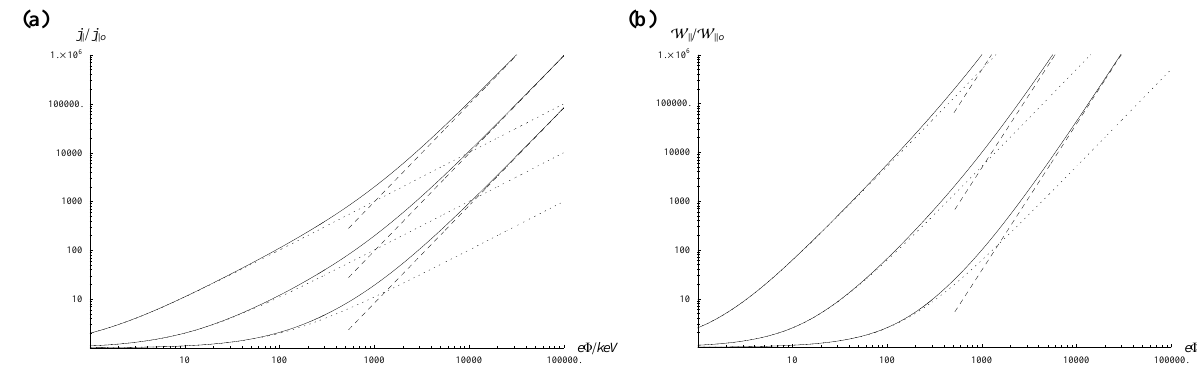
Fig. 5. Plots showing the variation of (a) the normalised field-aligned current density (cid:0) j || (cid:14) j || o (cid:1) (or number flux), and (b) the normalized field-aligned kinetic energy flux (cid:0) W || (cid:14) W || o (cid:1) , versus the minimum acceleration potential energy e8 in keV, given by Eqs. (33) and (34), respectively. The fluxes are normalised to the corresponding values for the unaccelerated population in each case, given by Eq. (17). The upper, middle, and lower solid lines in each panel show the relativistic flux values for kT = 1, 10, and 100keV, respectively, while the non- relativistic approximations given by Eqs. (35a, b) are shown by the corresponding dotted lines. The long-dashed lines show the final term only on the RH sides of Eqs. (33) and (34), plotted in the relativistic region where e8 ≥ mc 2 ≈